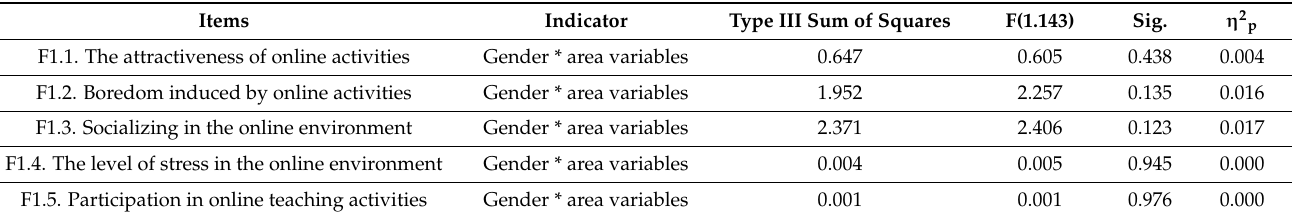
Table 3. Tests of between-subjects’ effects—the cumulative effect of gender variables * area variables on F1 factor items/attractiveness.